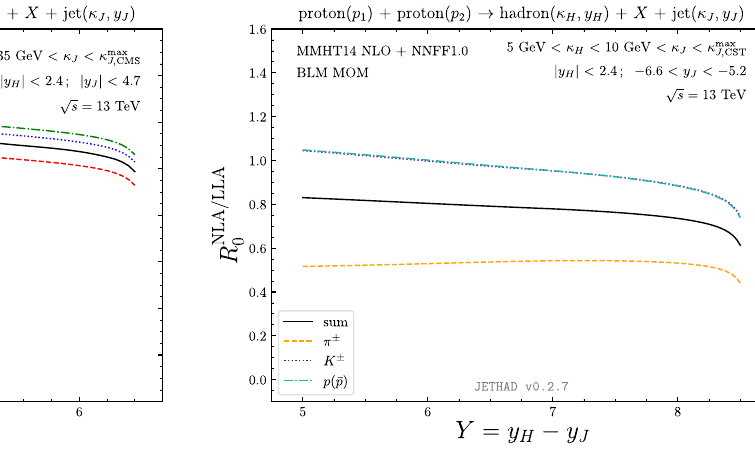
/ LLA Fig. 9 Y -dependence of the R NLA ratio for the inclusive hadron- for single hadron-species emissions ( π ± , K ± , p ( ¯ p ) ) are compared with 0 jet production (central panel in Fig. 2) in the asymmetric CMS (left) and the standard case, where the sum over all species is taken √ s = 13 TeV. Predictions in the CASTOR-jet (right) configuration, for